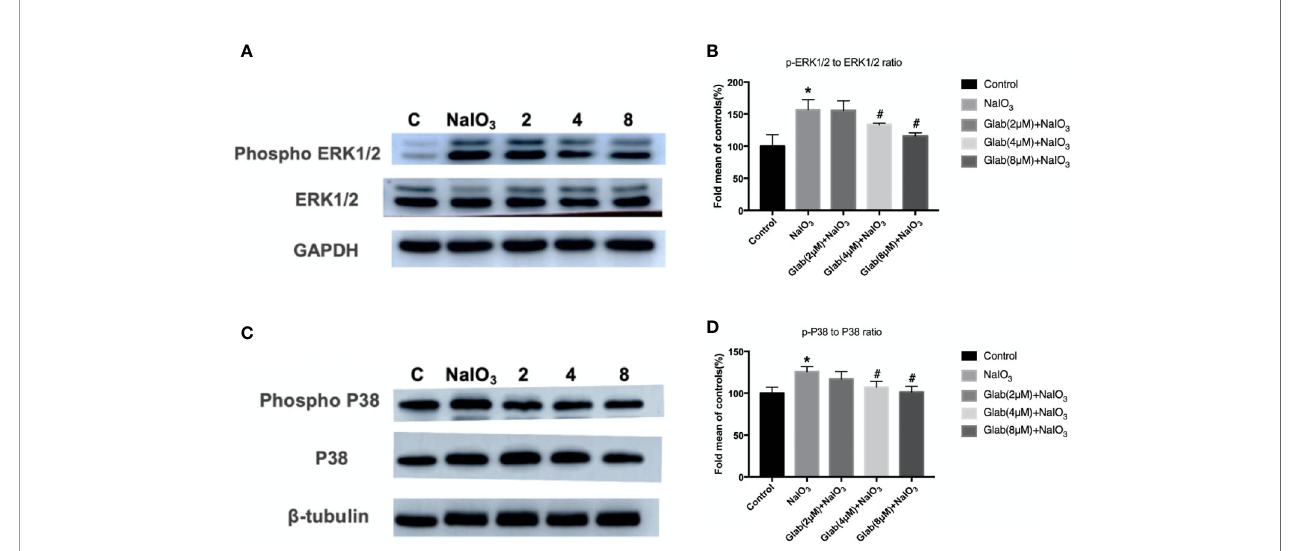
FIGURE 7 | Effects of Glabridin on the protein expression of phosphorylation of ERK1/2 and p38 in ARPE ‐ 19 cells treated with sodium iodate(NaIO 3 ) by Western blot detection. Control: retinal pigment epithelial (RPE) cells treated with DME-F12 only, NaIO 3 : RPE cells treated with NaIO 3 (1200 m g/ml), 2,4,8: RPE cells treated with different concentrations of Glab (2,4,8 m M) plus NaIO 3 (Glab+NaIO 3 ). (A) Effects of Glabridin on the phosphorylation of ERK1/2. (B) The expression of phosphorylated ERK1/2 was signi fi cantly increased in the NaIO 3 group, compared with the control group(* P < 0.05), while Glabridin signi fi cantly decreased the phosphorylation of ERK1/2 at the concentration of 4 and 8 m mol, compared with NaIO 3 group ( # P < 0.05). (C) Effects of Glabridin on the phosphorylation of p38. (D) The expression of phosphorylated p38 was signi fi cantly increased in the NaIO 3 group, compared with the control group (* P < 0.05), while Glabridin signi fi cantly decreased the phosphorylation of p38 at the concentration of 4 and 8 m mol, compared with NaIO 3 group ( # P <